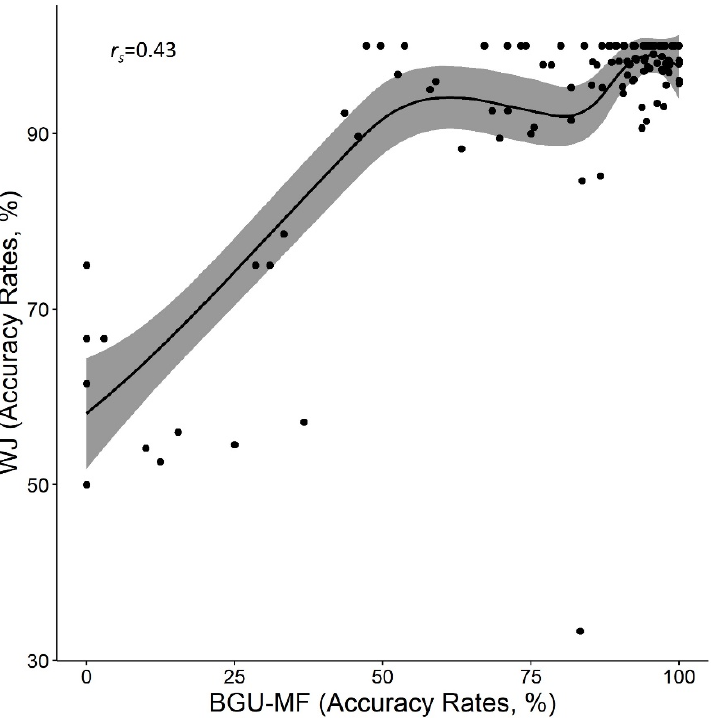
Figure 5 . Number of solved problems in both formats of the math fluency tests.